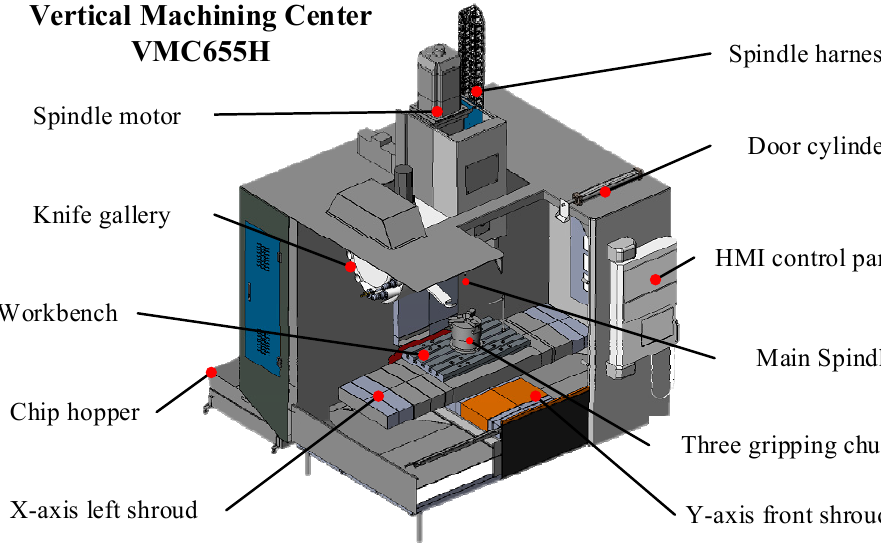
Figure 1. Vertical machining center VMC655H.